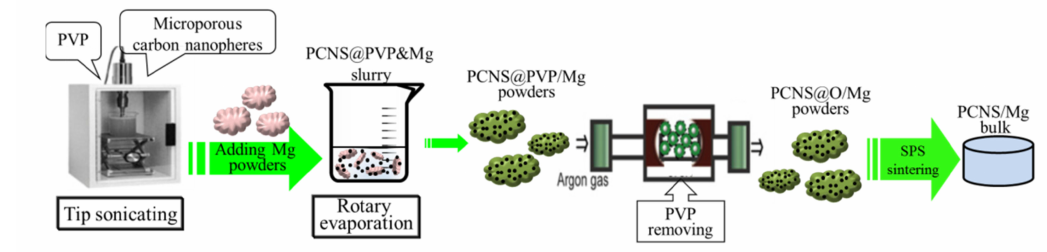
Figure 2. Preparation procedures for PCNS-reinforced Mg composite powders.